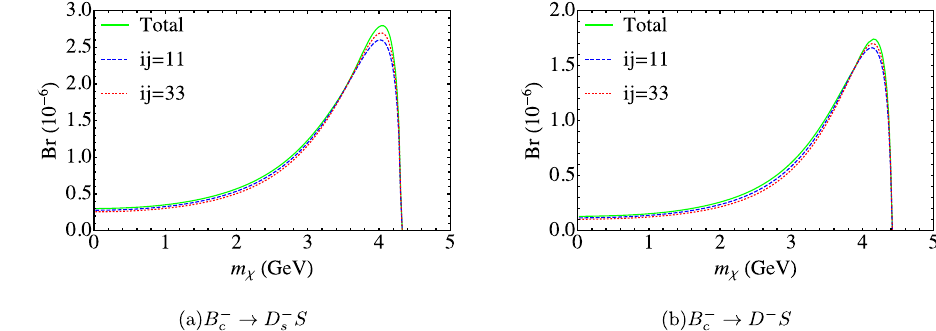
Fig. 4 Branching ratios of B c meson 0 − → 0 − decays with invisible